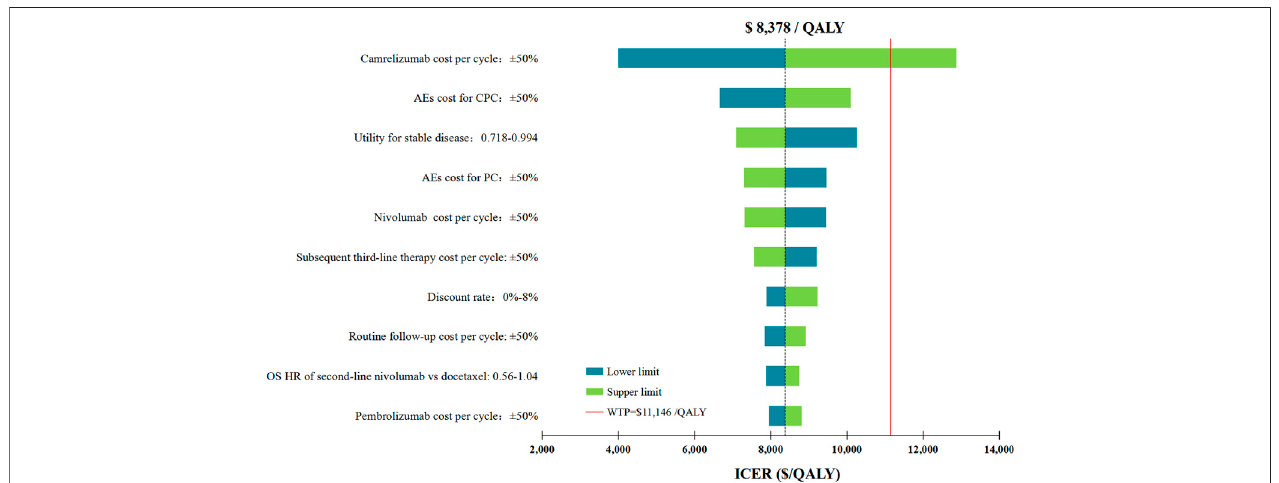
FIGURE 2 | Deterministic sensitivity analysis for the primary analysis. The red solid line represents the willingness-to-pay threshold of $11,146/QALY used in this study. The black dotted line represents the ICER of $ 8,378/QALY in the primary analysis. The top 10 variables by magnitude of effect are shown. ICER indicated incremental cost-effectiveness ratios; QALY, quality-adjusted life-years; AEs, adverse events; OS, overall survival; CPC, camrelizumab in combination with pemetrexed and carboplatin; PC, pemetrexed plus carboplatin.